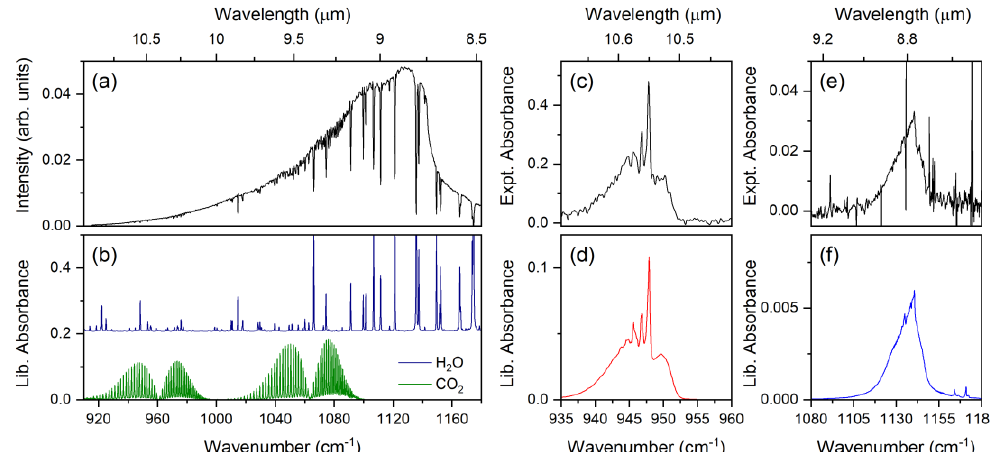
Figure 3. Example spectra obtained with swept-ECQCL standoff system. ( a ) Measured intensity versus wavenumber/wavelength after propagation over an atmospheric path with 3 km total distance. The data are averaged over 10 s. ( b ) Library spectra for H 2 O and CO 2 simulated using HITRAN parameters and scaled for a column density of 10 6 ppm × m. The spectra are offset for clarity. ( c ) Measured absorbance spectrum for SF 6 (10 s average). ( d ) Library absorbance spectrum for SF 6 , scaled for 1 ppm × m. ( e ) Measured absorbance spectrum for F152a (10 s average). ( f ) Library absorbance spectrum for F152a scaled for 1 ppm × m.